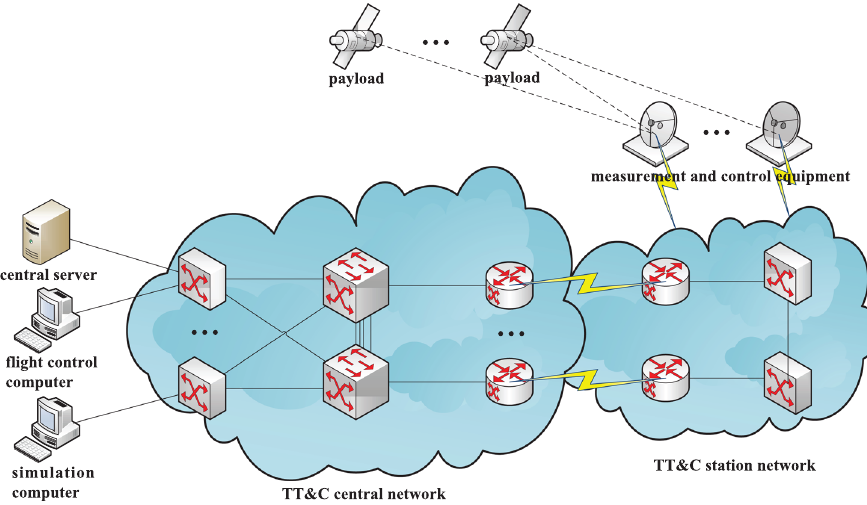
Figure 1: Space TT&C network topology of data